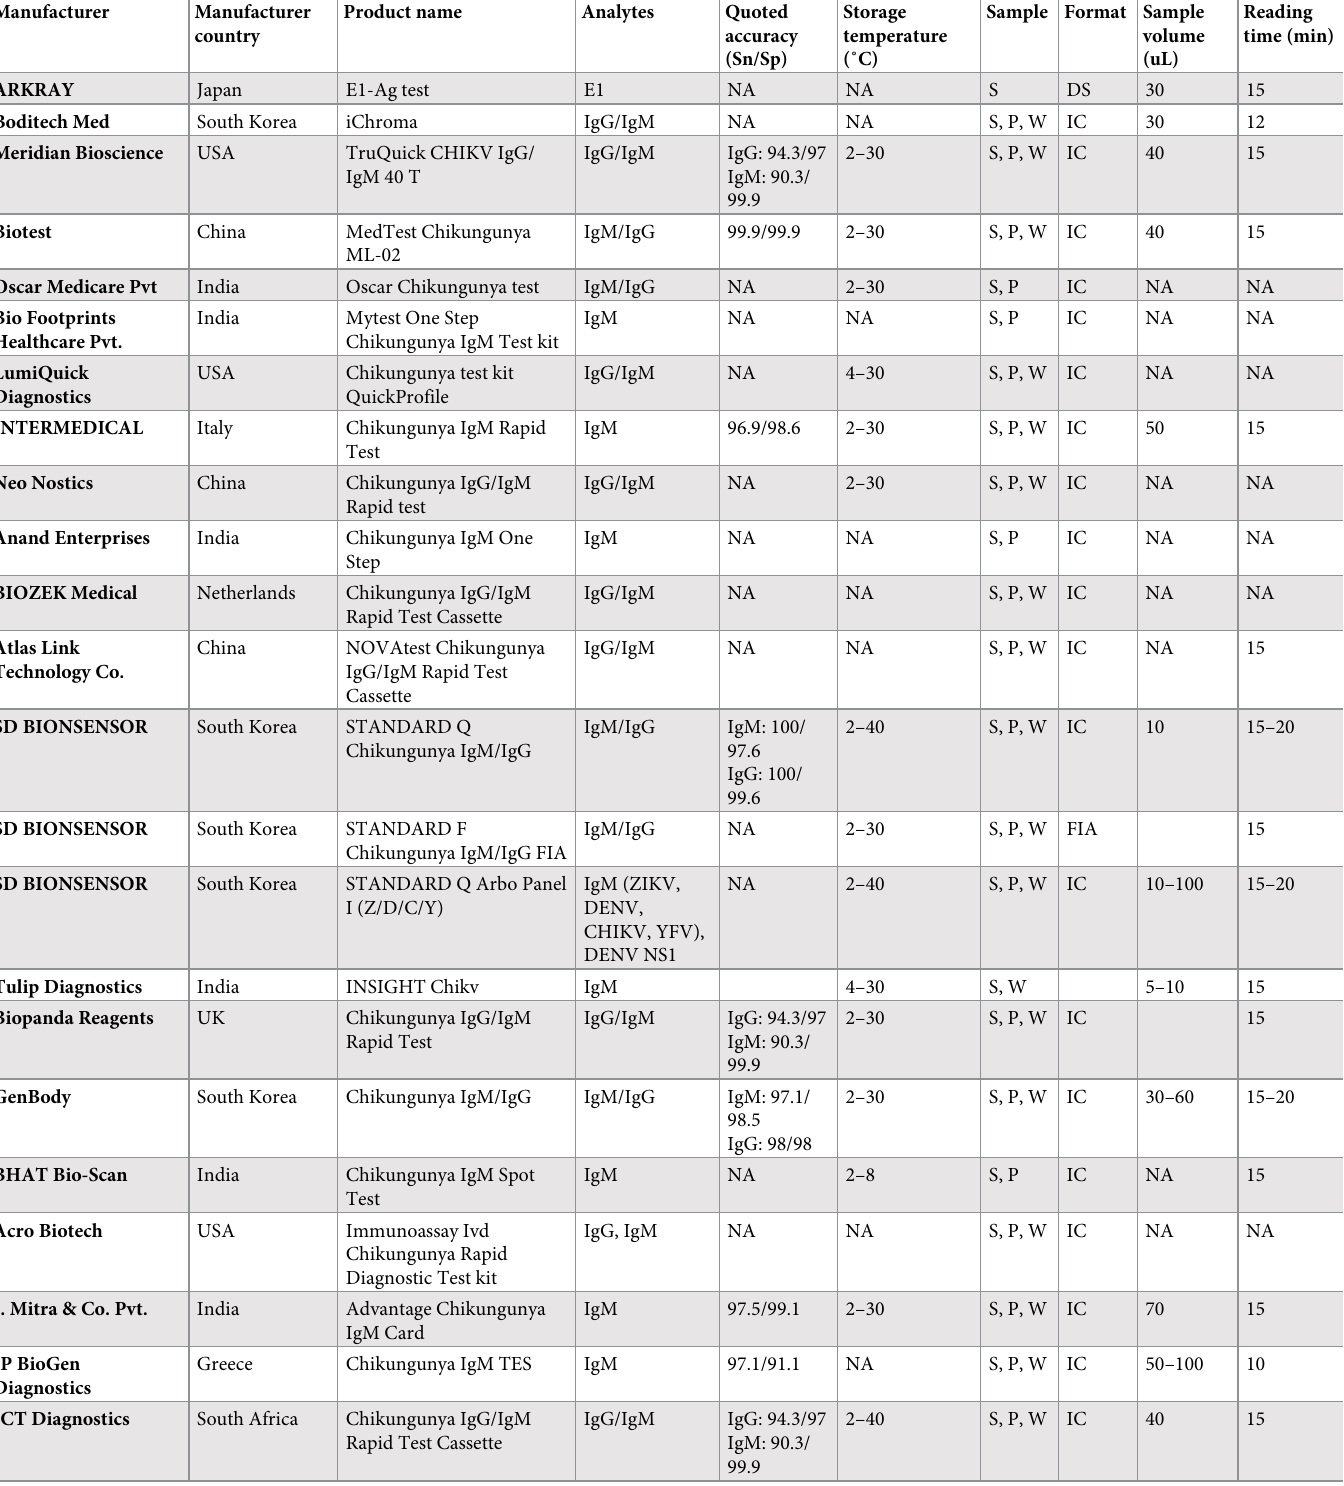
Table 2. Characteristics of Chikungunya rapid diagnostic tests developed or commercialized for point-of-care application.